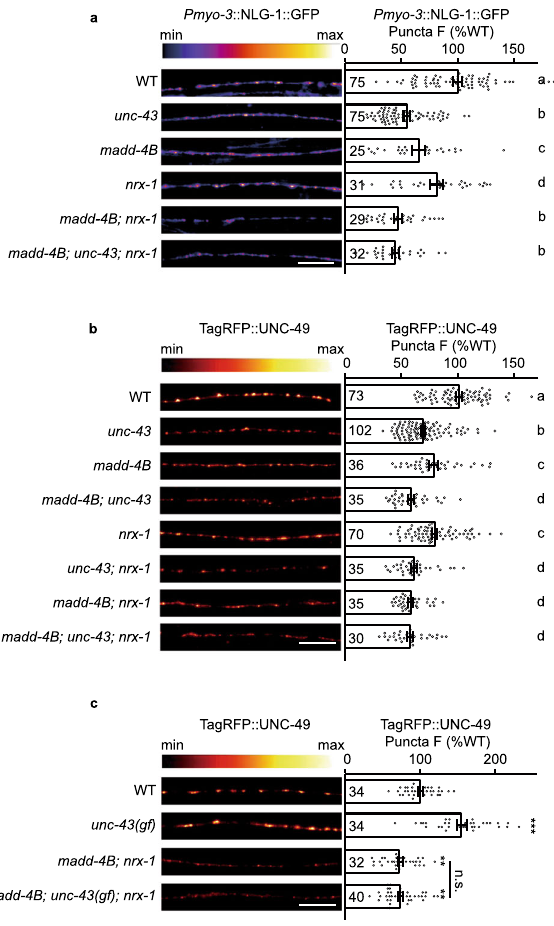
Fig. 5 | UNC-43/CaMKII ’ s recruitment ofGABA A Rsrequiresboth MADD-4Band NRX-1 α . a UNC-43 functions in the same pathway with MADD-4B and NRX-1 α to stabilize postsynaptic NLG-1 localization. NLG-1-GFP fl uorescence intensities in the body-wall muscles in wild type and mutants were shown. Representative images (left, scale bar 10 μ m, Pseudo-color: Fire) and mean puncta intensities+/ − SEM (right, Ns represent the number of animals tested) are shown. The data for WT and unc-43 arethesameasinFig.4c.Kruskal – Wallistestwithtwo-stagelinearstep- up procedure of Benjamini, Krieger, and Yekutieli correction for multiple com- parisons. The scatter plotted data labeled with different letters are signi fi cantly different ( p <0.05). b , c Both MADD-4B and NRX-1 α are required for UNC-43 ’ s recruitmentofGABA A Rs.TagRFP-UNC-49 fl uorescenceindorsalnervecordsinwild type and mutants is shown. Representative images (left, scale bar 10 μ m, Pseudo- color: Red Hot) and mean puncta intensities+/ − SEM (right, Ns represent the numberofanimalstested)areshown.In b ,Kruskal – Wallistestwithtwo-stagelinear step-up procedure of Benjamini, Krieger, and Yekutieli correction for multiple comparisons.Thescatterplotteddatalabeledwithdifferentlettersaresigni fi cantly different ( p <0.05). In c , Kruskal – Wallis test with post-hoc Dunn ’ s test. ** p <0.01, *** p <0.001, n.s. not signi fi cant. For a – c , source data are provided as a Source Data fi